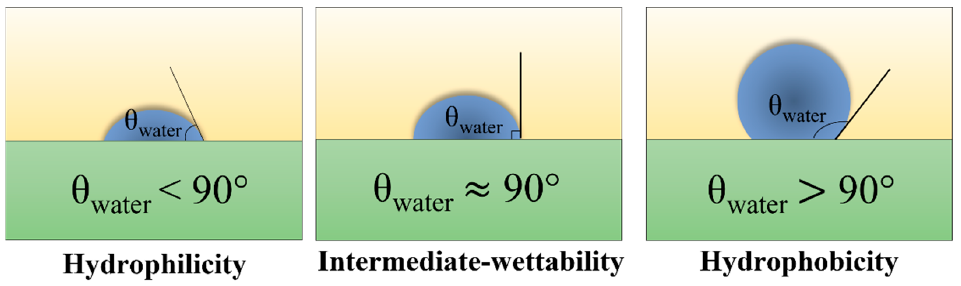
Figure 7. Diagram of water contact angle measurement [41].